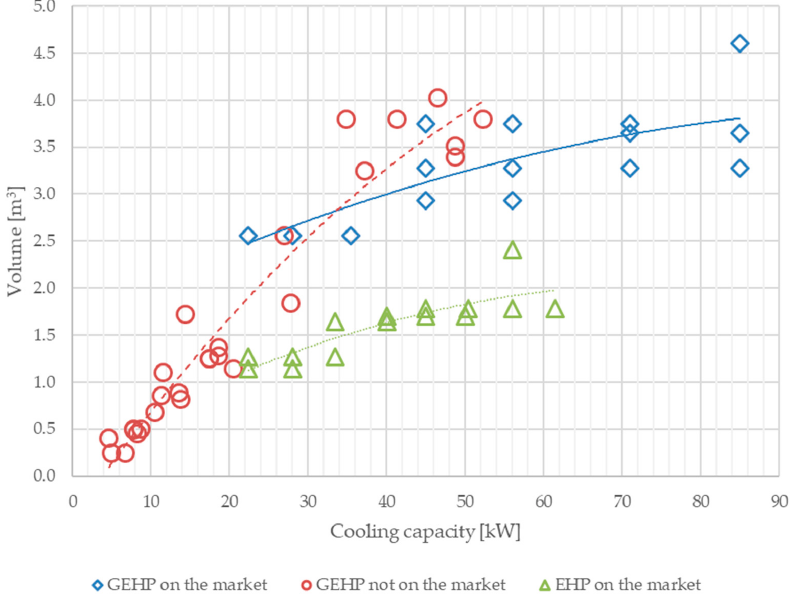
Figure 6. Volume of GEHPs (oldest and commercialised) and EHPs as a function of cooling capacity.